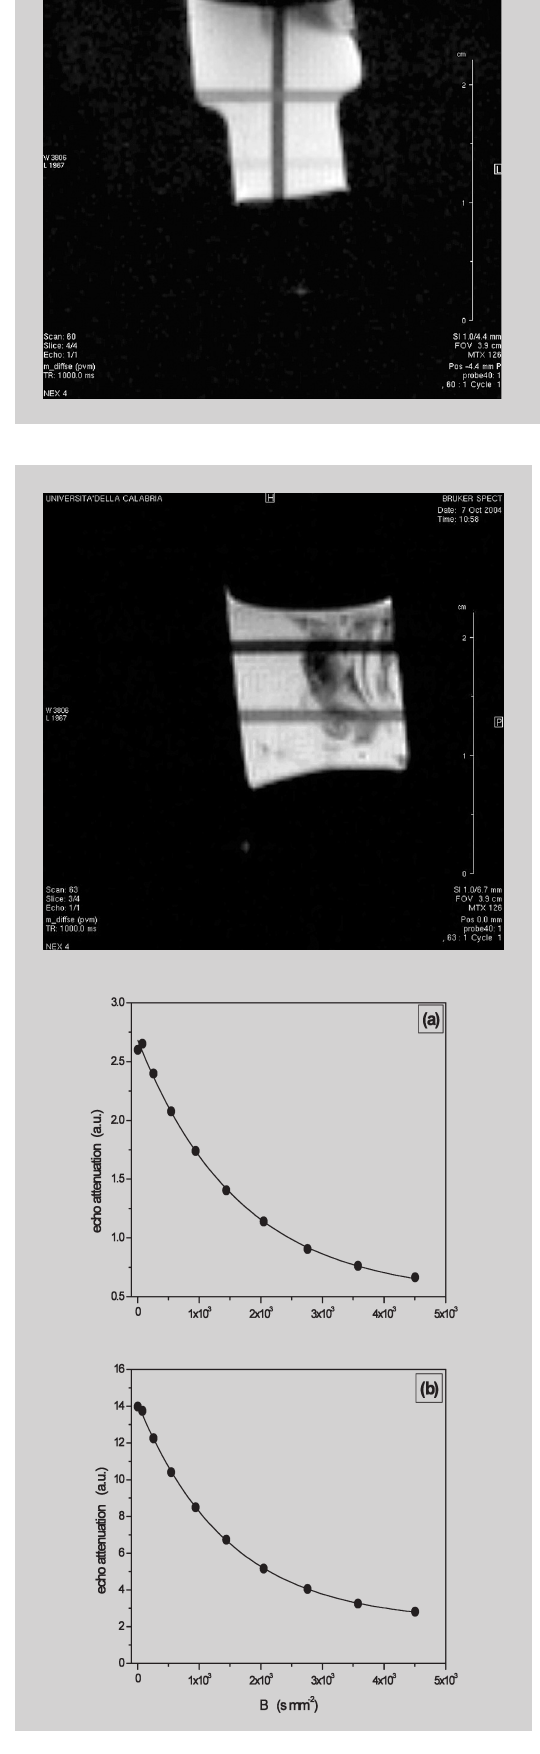
Figure 6 (above): Self diffusion image for the sample during slow flow at 15°C, representing a map of mobility of protons inside the sample (a). The echo attenuation as a function of the experimental B parame- ter. The solid lines is the best fit to data using Eq. 2 (b). Figure 7: Self diffusion image for the sample after strong shear- ing at 15°C and the echo attenuation plot for the lat- eral zone (a) and for central zone (b) of the sample. The solid lines are the best fit to data using Eq.